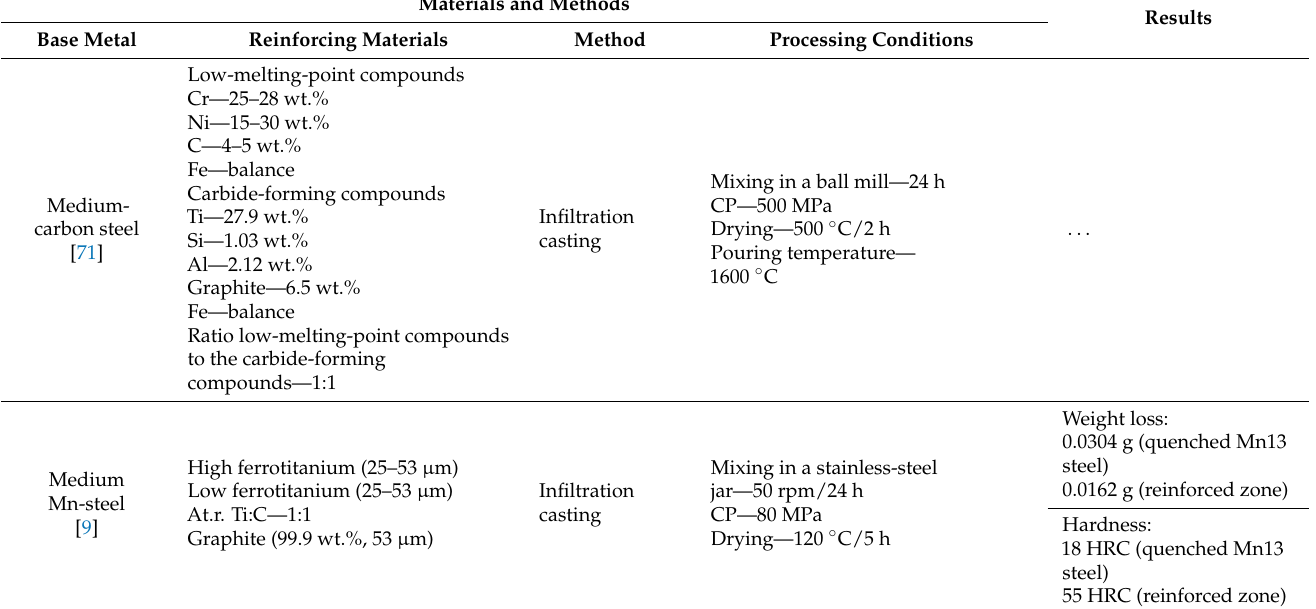
Table 5. Summary of experimental conditions and main results of SHS/casting processing using Fe-Cr-Ti-C powder system. Materials and Methods Base Metal Method Processing